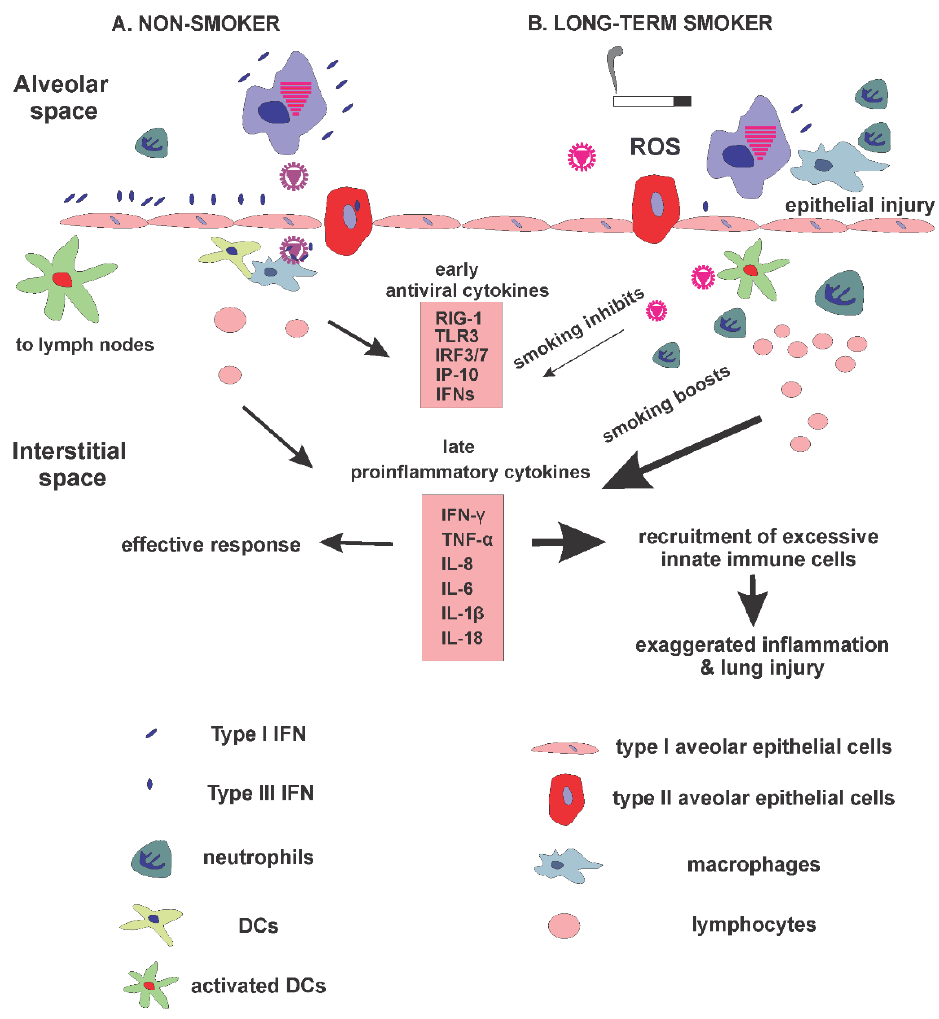
Figure 1. Cigarette smoking changes host innate responses during influenza virus infection. ( A ) Influenza virus-induced innate response in non-smokers. Normal responses are an exquisitely balanced biological control mechanism. ( B ) Influenza virus-induced innate response in long-term smokers. CS potentially inhibits antiviral PRR responses and cytokine induction while it boosts inflammatory cytokine induction and enhances lung injury.